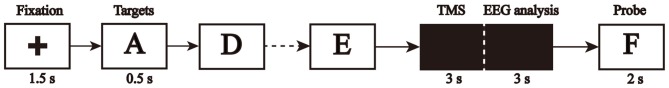
Flow diagram of the single-pass working memory (WM) test of letters.